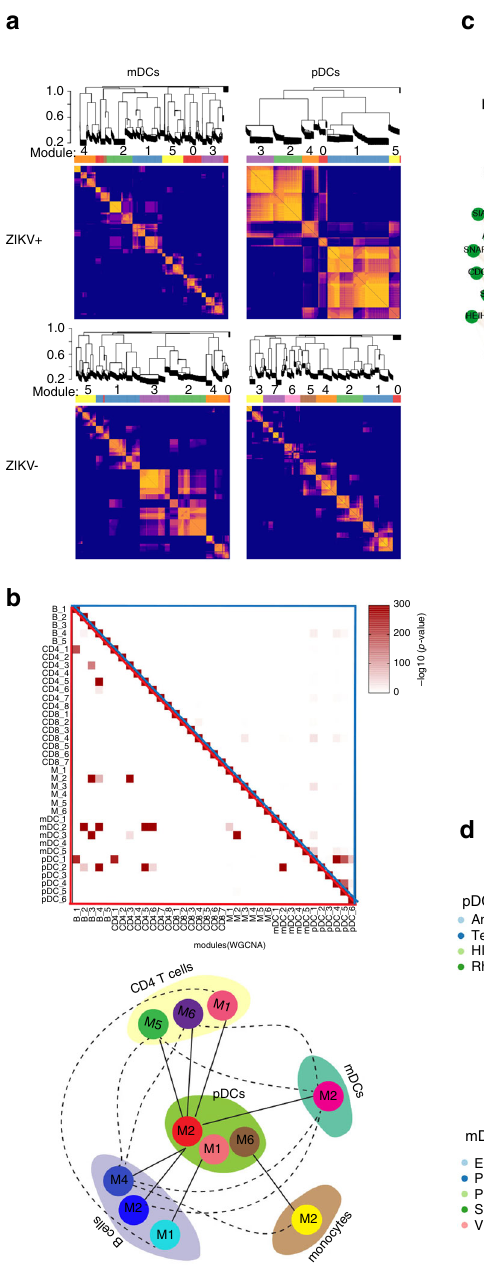
Fig. 5 Gene module correlation analysis highlights distinct but integrative role of pDCs for antiviral immune defense against ZIKV. a Heatmaps highlighting modules of transcripts with correlated gene expression patterns in indicated immune cells subsets from ZIKV-infected (ZIKV + ) and noninfected individuals (ZIKV − ). b Uupper panel: Correlation analysis of individual gene modules from indicated cell compartments de fi ned in ZIKV- infected patients, applied to transcriptional pro fi ling data from ZIKV-infected patients (red-framed triangle) or from ZIKV-noninfected individuals (blue- framed triangle). Lower panel: Graphic illustration of interconnected gene modules from different immune cell subsets of ZIKV-infected patients . c Network of correlated genes within B-cell module 2 and 4, CD4 module 5 and 6, mDC module 2 and pDC module 2. Signi fi cant correlations between genes expressed in different cell subtypes are represented by gray lines. Size of the genes symbols indicates the number of connections. d Circos plot highlighting co-expressed genes, categorized according to cell types, gene modules, and predicted functional